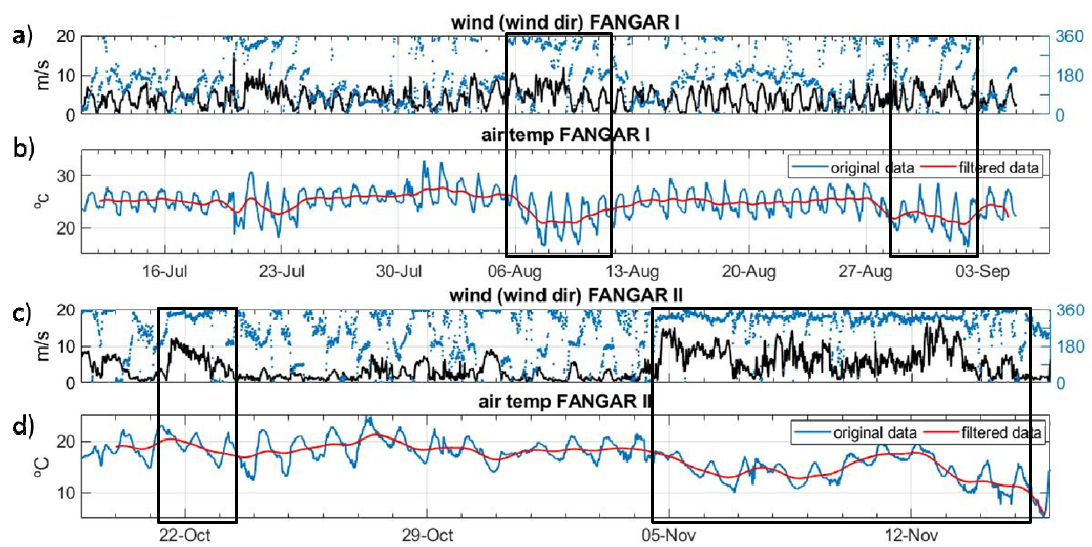
Figure 4. Wind direction and intensity from FANGAR-I ( a ) and FANGAR-II ( c ). Air temperature for FANGAR-I ( b ) and FANGAR-II ( d ). Air temperature is filtered to exclude daily variability. The black box shows the periods with falling air temperatures during NW winds.